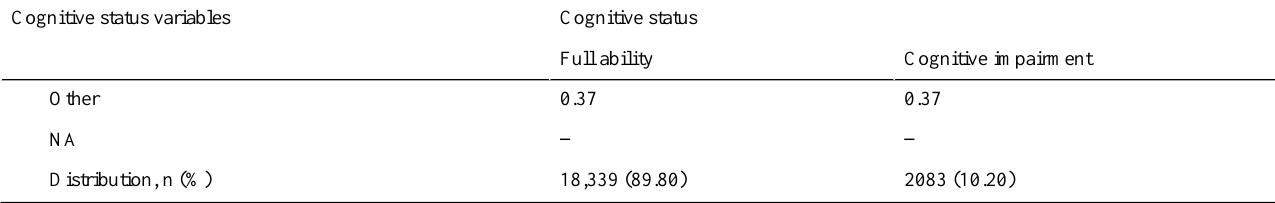
cognitive health, 4290/20,422 (21.01%) with mild cognitive impairment, and 415/20,422 (2.03%) with severe cognitive impairment. The 3-cluster solution’s results were similar to those of the 2-cluster solution (Table